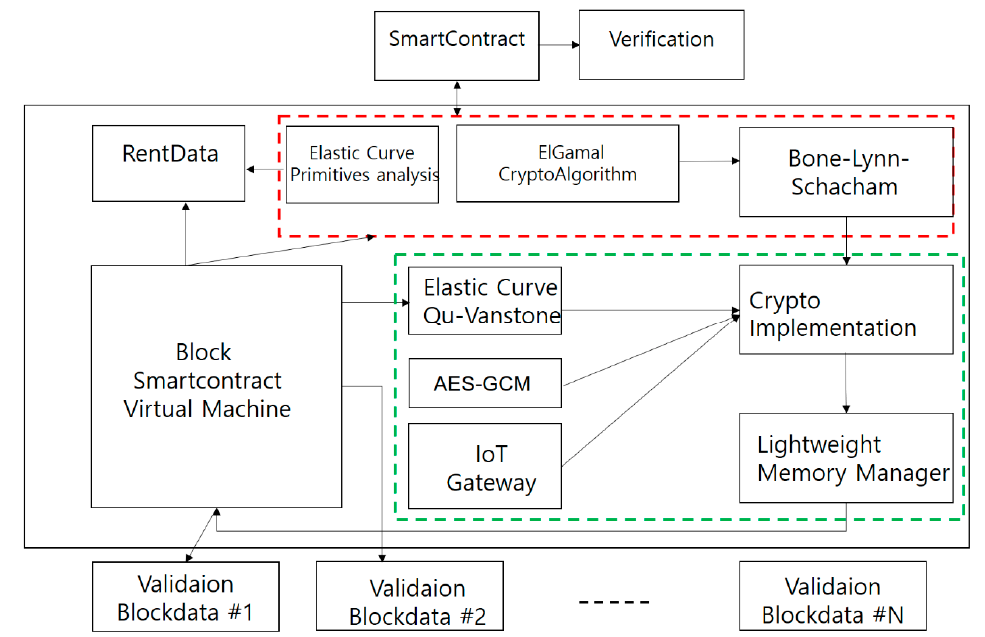
Figure 6. Smart contract architecture for real estate.